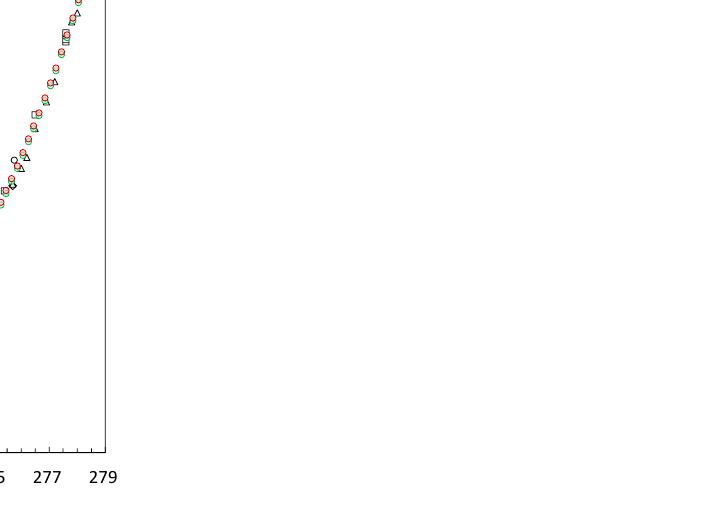
Figure 2. Three-phase (ice/water + hydrate + vapor) equilibrium p – T conditions for 12 CO 2 and 13 CO 2 hydrates. Green circles, 12 CO 2 –H 2 O (this work); brown circles, 13 CO 2 –H 2 O (this work); open squares, 12 CO 2 –H 2 O [24]; open triangles, 12 CO 2 –H 2 O [25]; open diamonds, 12 CO 2 –H 2 O [26]; open circles, 12 CO 2 –H 2 O [23].